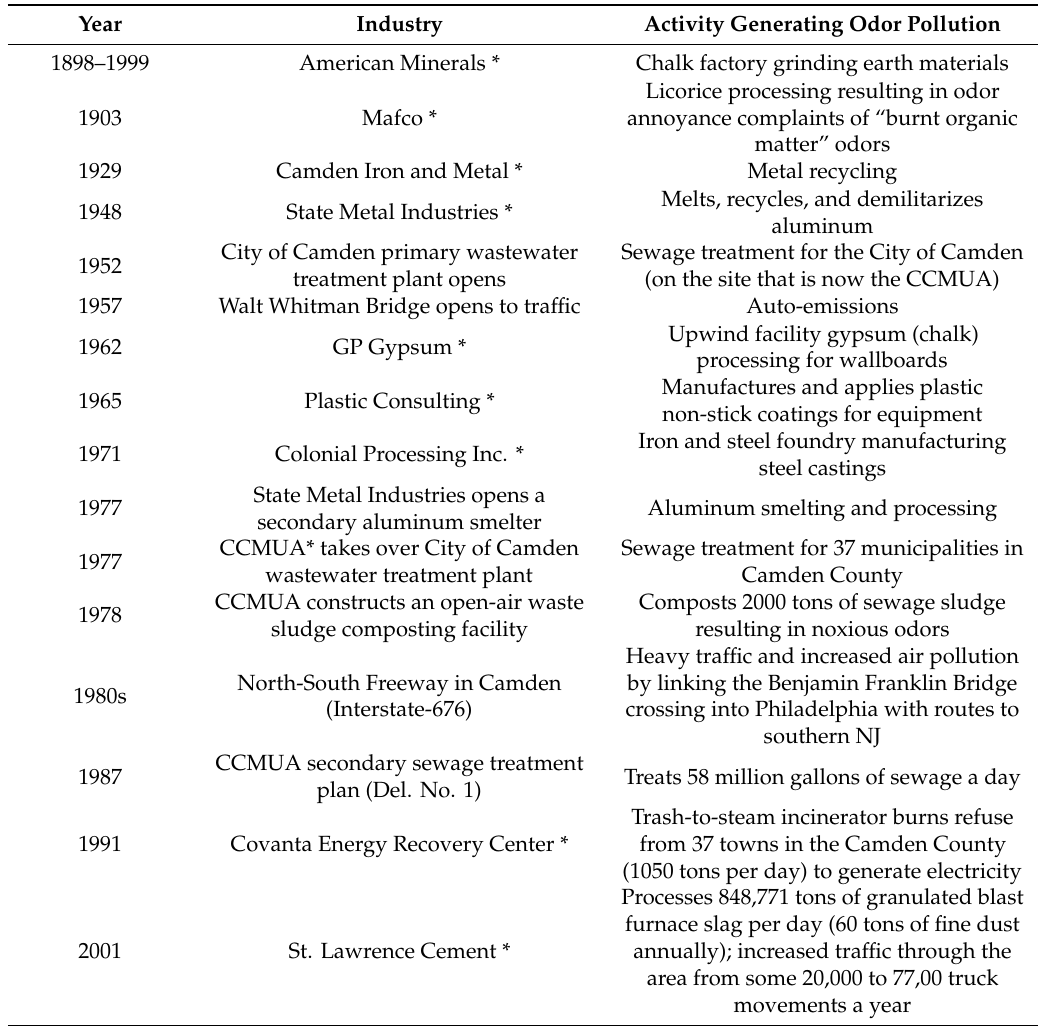
Table 1. The timeline of odor pollution activities a ff ecting the Waterfront South neighborhood, compiled by the authors [28–30]. Unless otherwise indicated, all activities are still operational in 2019. Facilities indicated with an asterisk were identified by the New Jersey Environmental Taskforce as having a significant impact in contributing to one or more air pollutants between 2002–2005